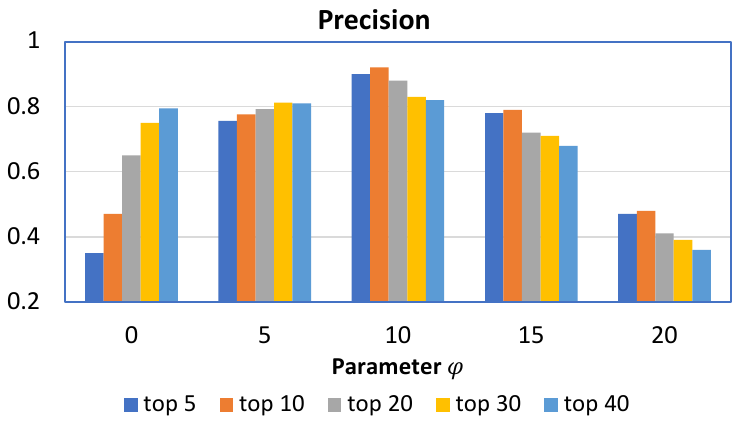
Figure 9. Impact of the parameter ϕ on the precision of